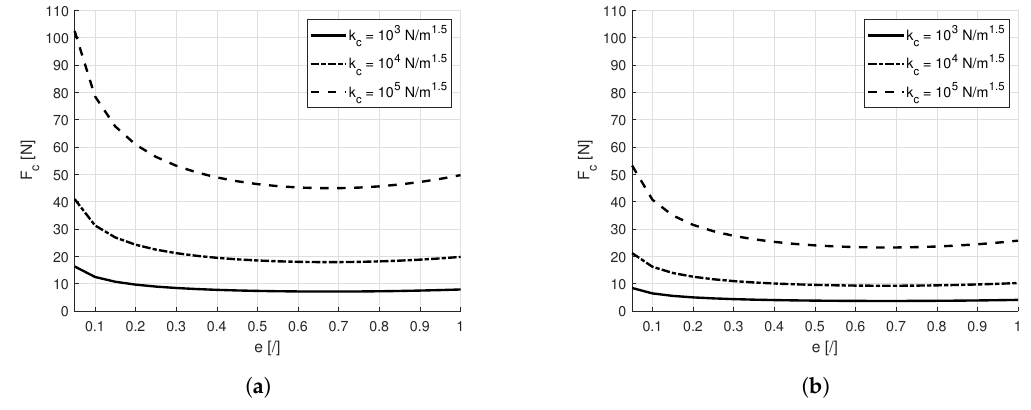
Figure 6. Influence of k c and e on contact force. ( a ) Limit case of Figure 4a; ( b ) limit case of Figure